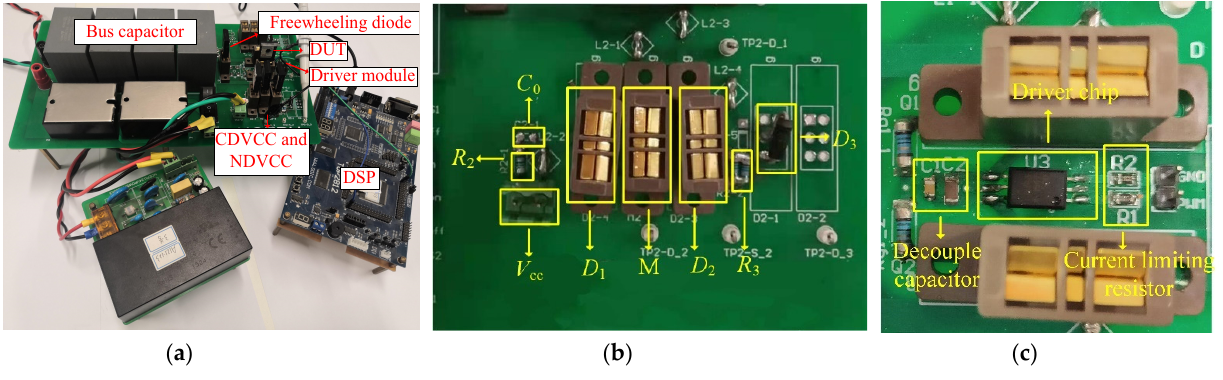
Figure 4. Test platform. ( a ) Test platform overview; ( b ) DVCC section; ( c ) gate driver.